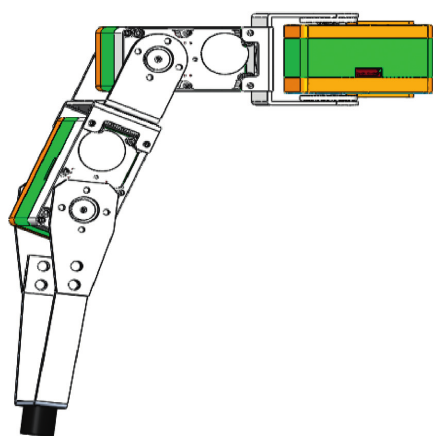
Figure 2: The structure of robotic